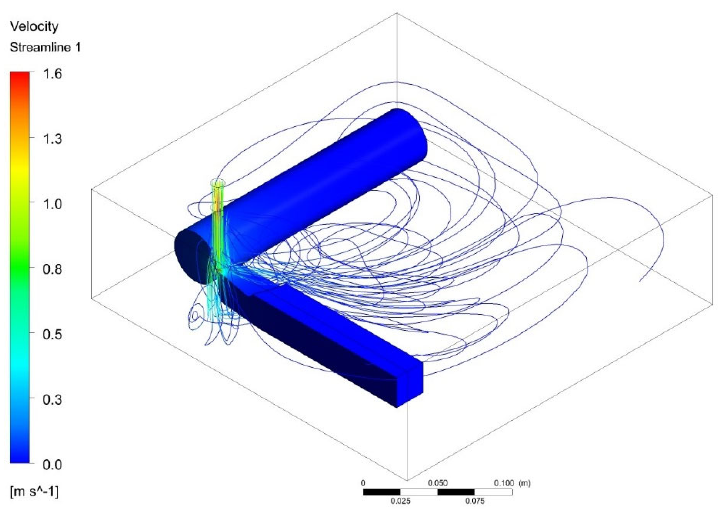
Figure 9. Streamlines depicting the flow of coolant from a nozzle to the machining zone.